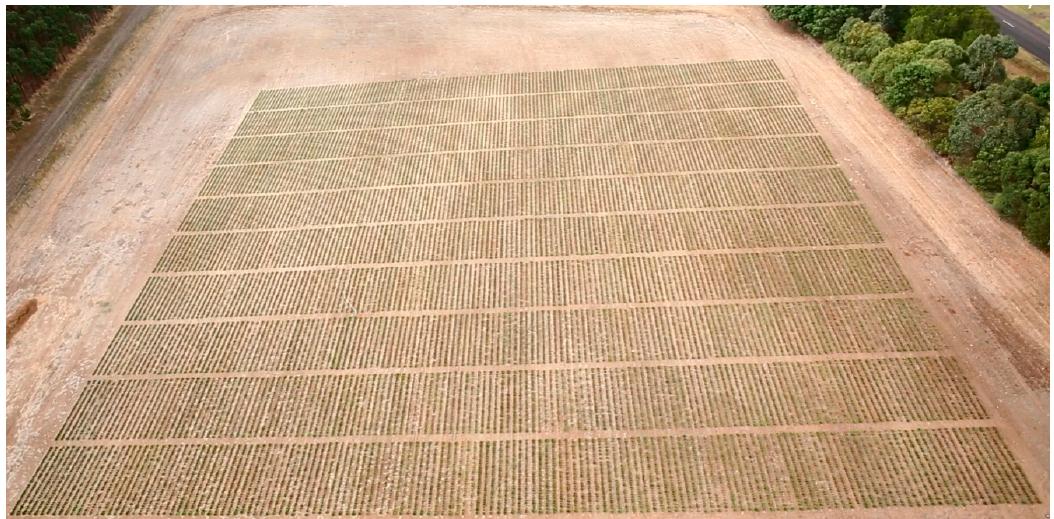
Figure 1. The field trial of 50 experimental perennial ryegrass cultivars grown as 48,000 individual plants in 50 plots of 96 with ten replicates.